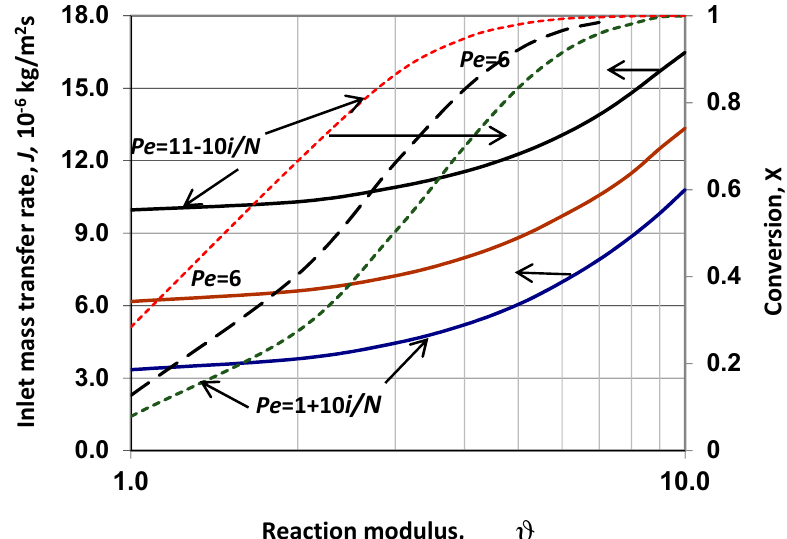
Figure 10. The relative values of the inlet mass transfer rate, J / J ◦ , and the conversion, X , are plotted as a function of the reaction modulus at three di ff erent cases, namely with a lowering, increasing, and constant Peclet number, i.e., Pe i = Pe o ( 11 − 10 i / N ) Pe i = Pe o ( 1 + 10 i / N ) and Pe = constant ( Pe =